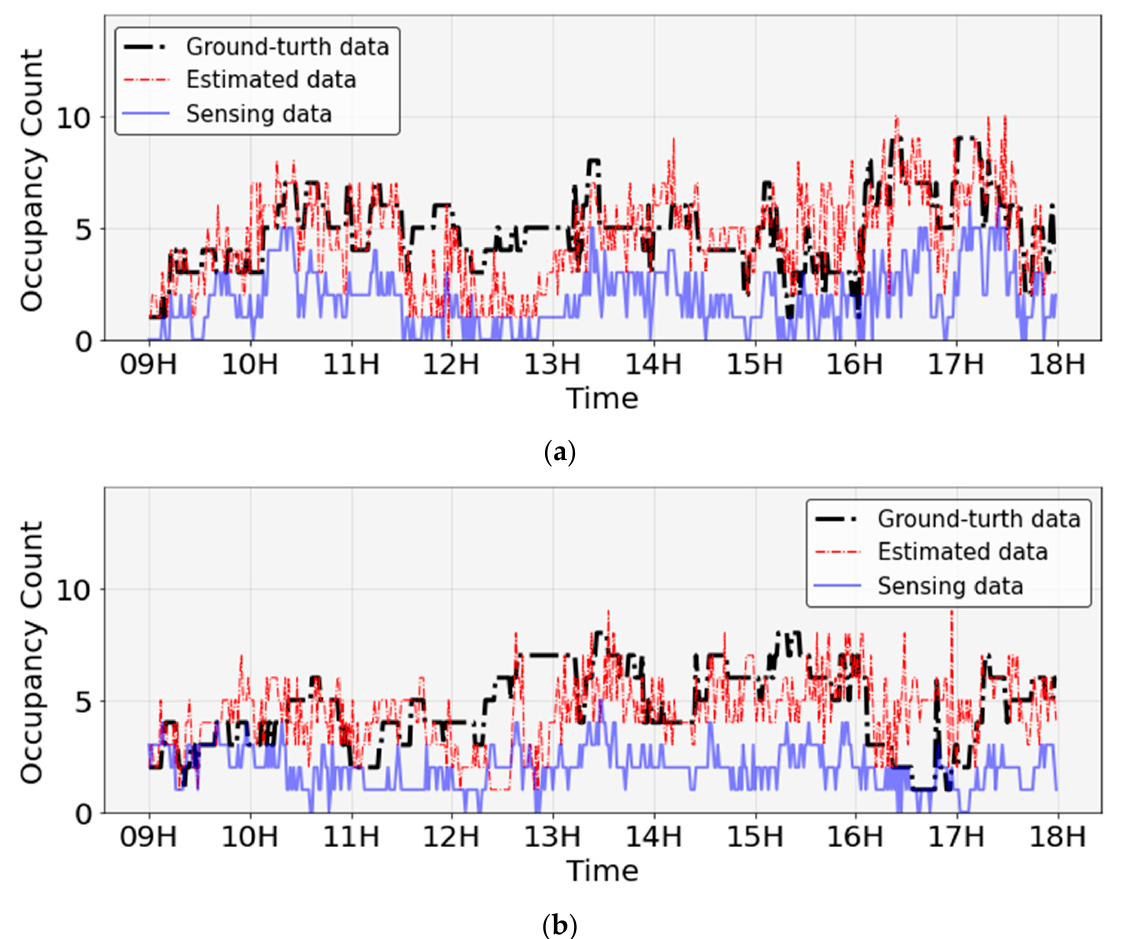
Figure 11. Estimation of occupancy using deep learning: ( a ) room 1; ( b ) room 2.